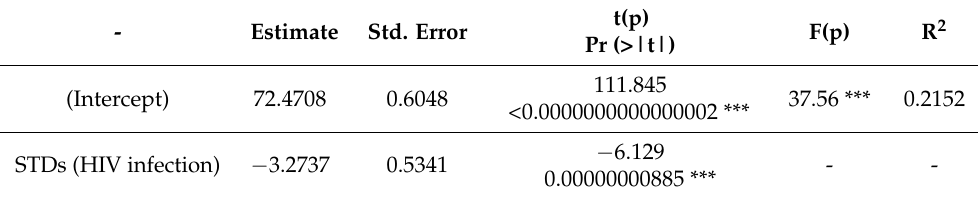
Table 14. Regression between STDs (HIV infection) and life expectancy. - Estimate Std. Error